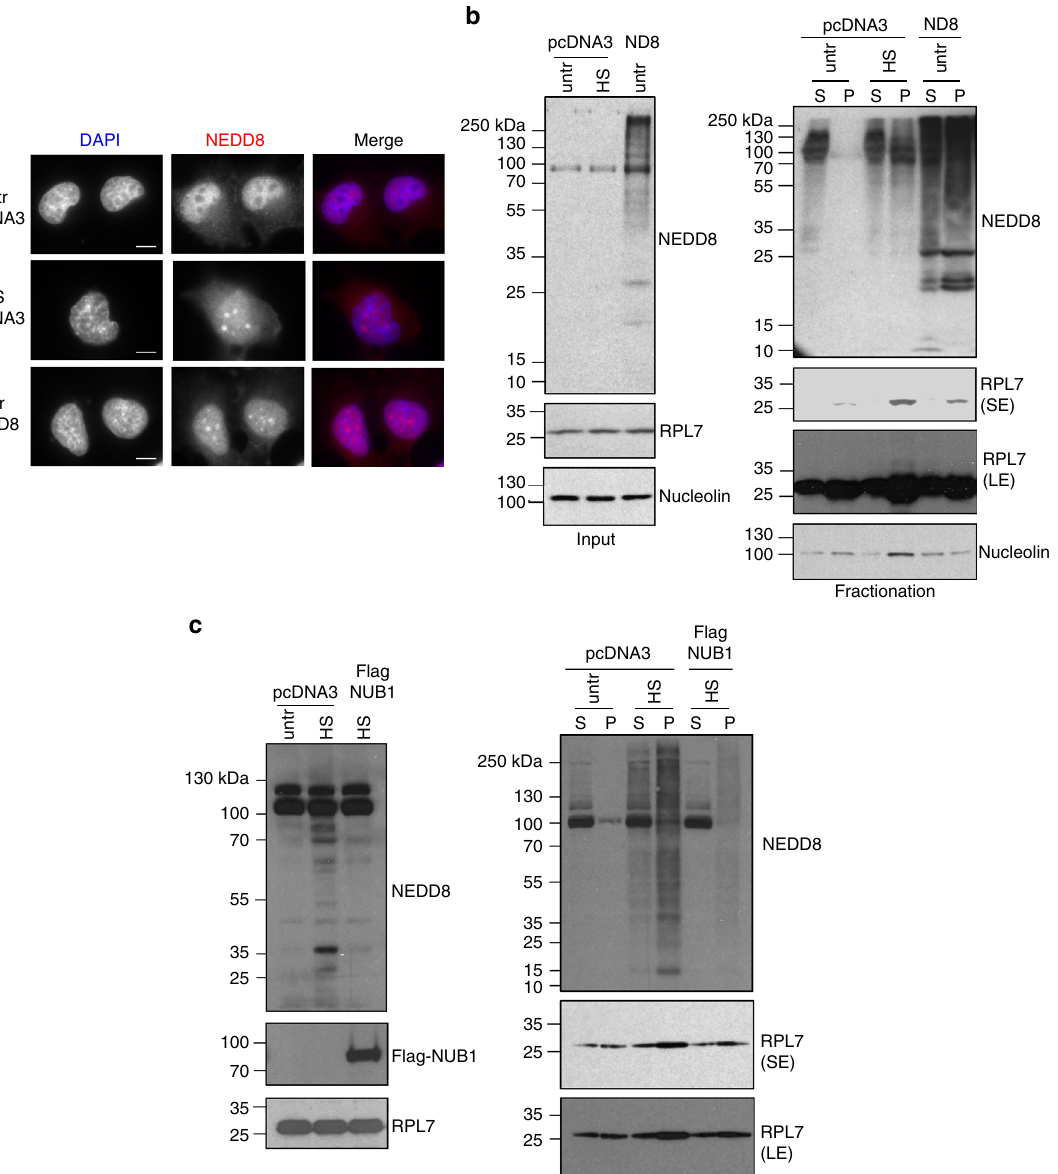
Fig. 6 Overexpression of NEDD8 promotes protein aggregation. a H1299 cells were transfected either with empty pcDNA3 vector or NEDD8 expression constructs. Cells were heat-shocked for 2 h at 43 °C and were stained for NEDD8 and DAPI. Scale bars, 10 µ m. b Similar experiment as in a and fractionation was performed to isolate soluble (S) and insoluble proteins from the pellet (P). Western blotting was performed for the indicated proteins (SE Short exposure, LE Long exposure). c Similar experiment as in a with the exception that Flag-NUB1 (5 μ g) construct was